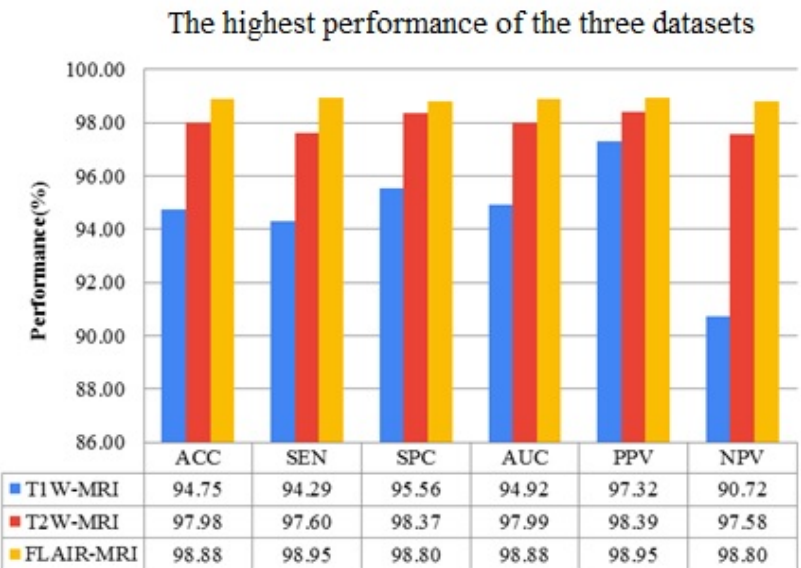
Table 13. The model-wise average performance of three datasets.